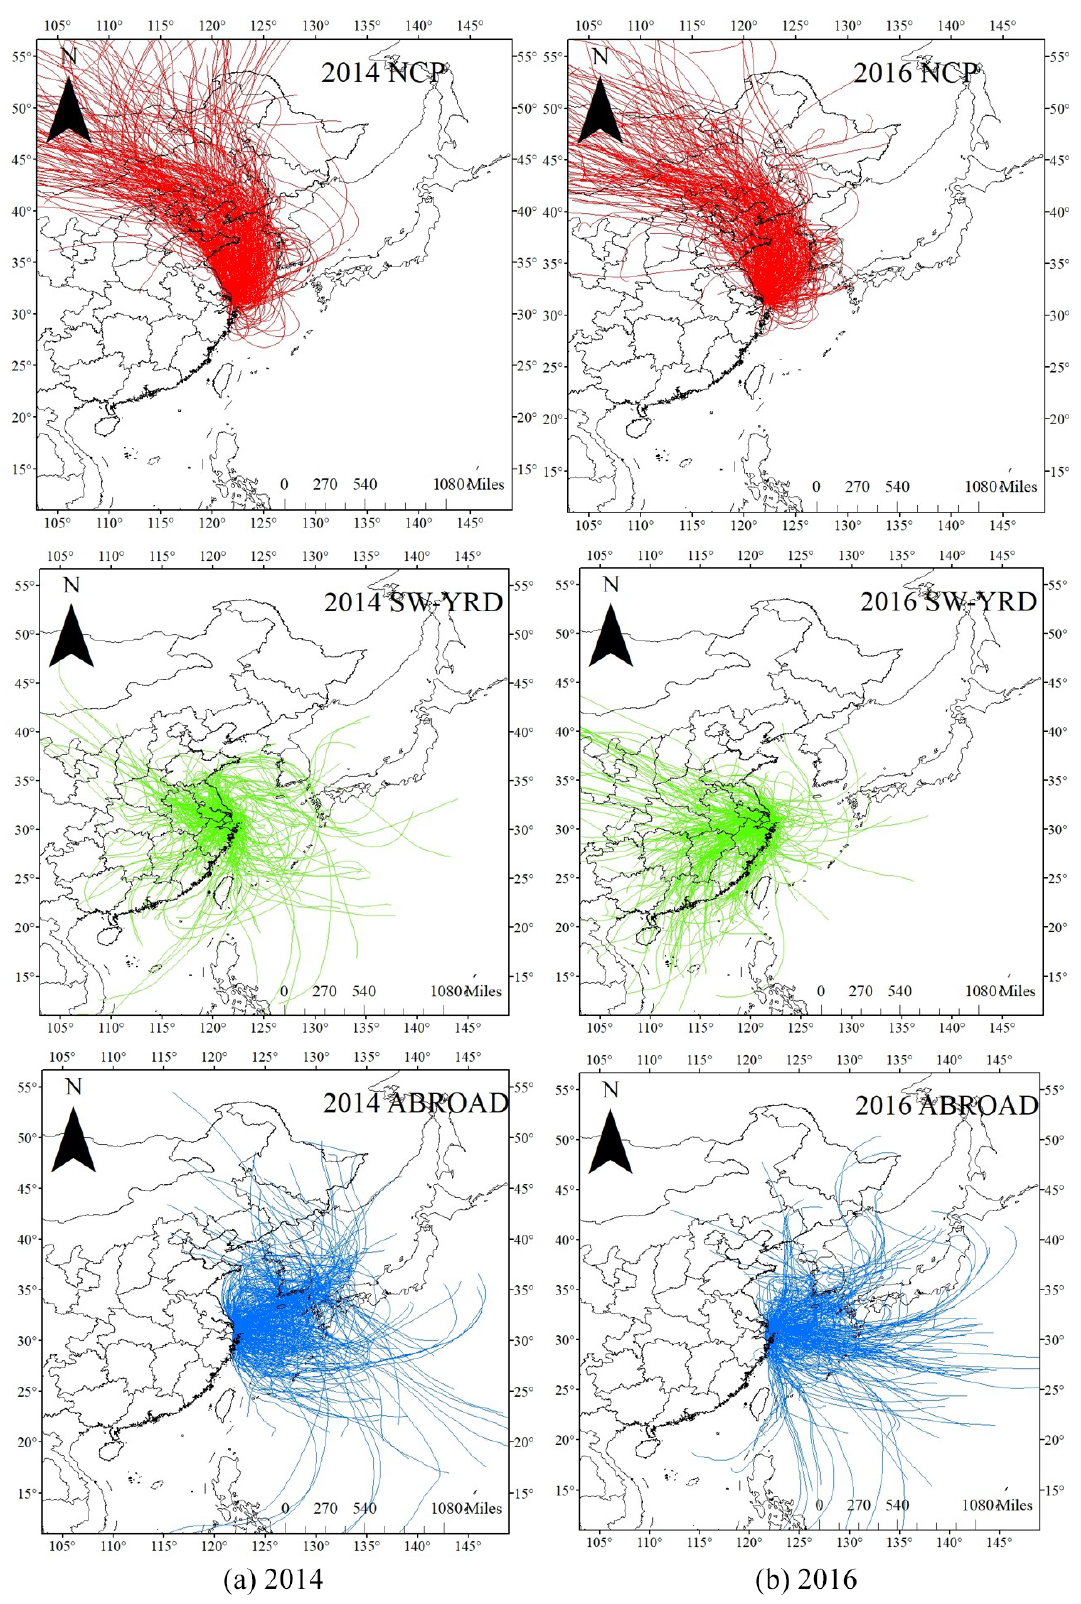
Figure 6. The back trajectories map for cluster NCP, SW-YRD and ABROAD in (a) 2014 and (b) 2016. (NCP – North China Plain, SW-YRD – southwestern region and the Yangtze River Delta, and ABROAD –